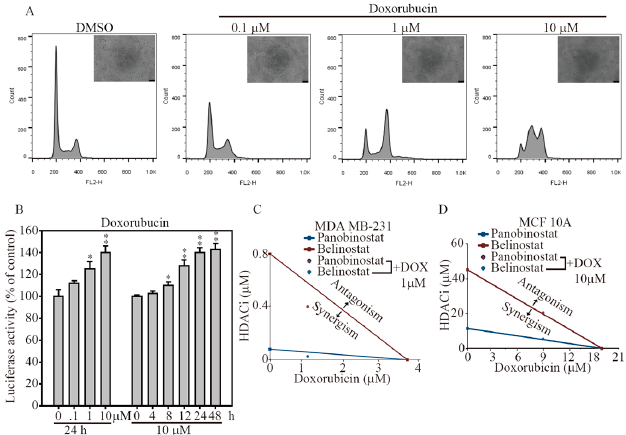
Figure 5. HDACi synergiclly enhances anti-cancer activity of doxorubicin through NIADS